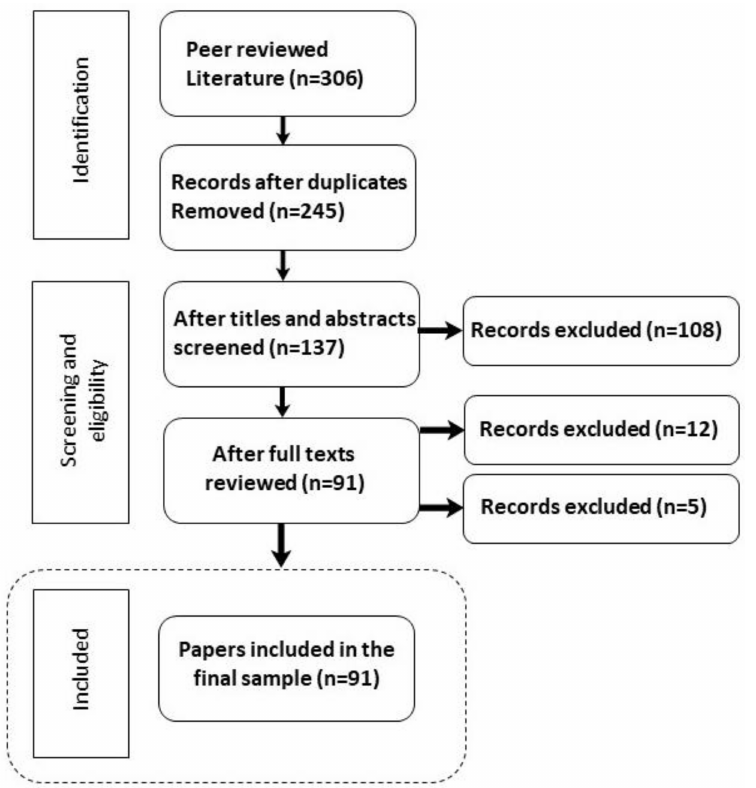
Figure 1. Flow diagram showing the methodology based on PRISMA procedure adapted from Moher et al.